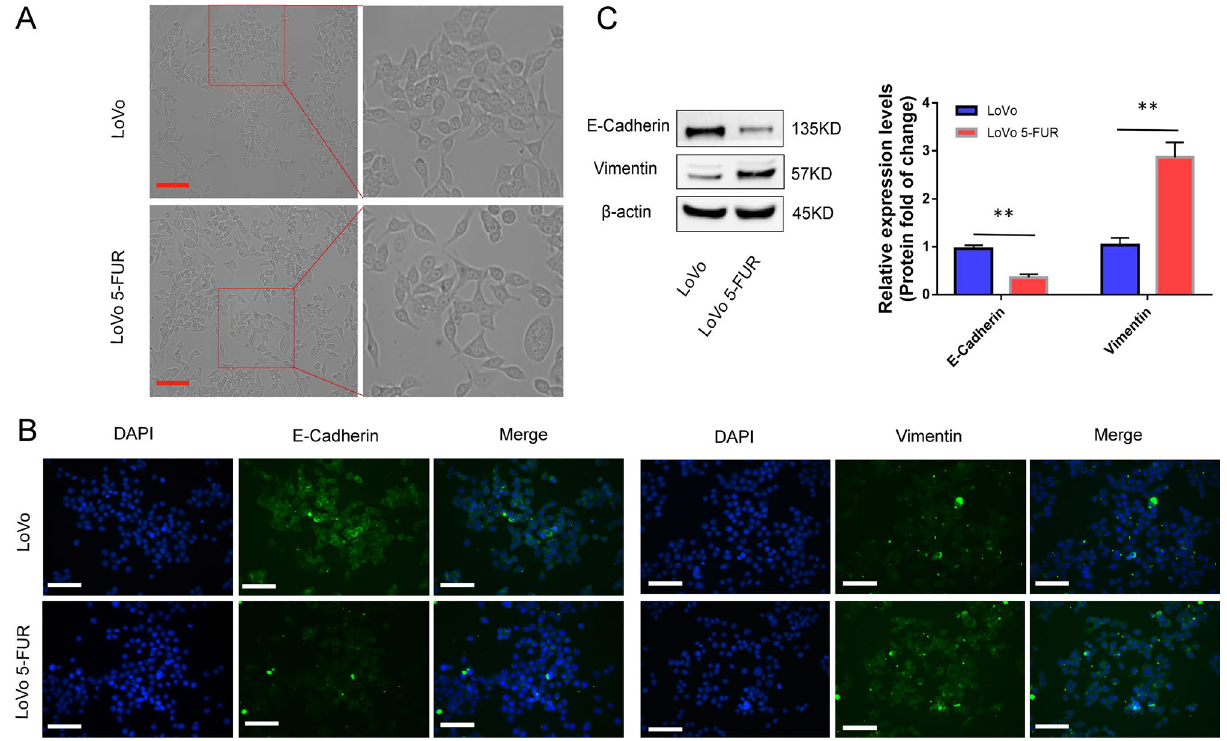
Figure 3. Low levels of DYRK2 expression are associated with changes in CRC cell epithelial–mesenchymal phenotype. ( A , B ) Changes in cellular morphology and EMT marker localization. ( A ) Light microscopy was used to assess cellular morphology in a monolayer. Scale bar: 50 μm (× 200). ( B ) E-cadherin and Vimentin localization in LoVo and 5-FUR LoVo cells was assessed via immunofluorescent staining for DAPI (blue) and secondary antibodies (green). Scale bar: 50 μm (× 200). ( C ) EMT marker protein levels were detected via Western blotting and assessed with ImageJ. β-Actin served as a loading control. Data are means ± SD (n = 3). ** P <